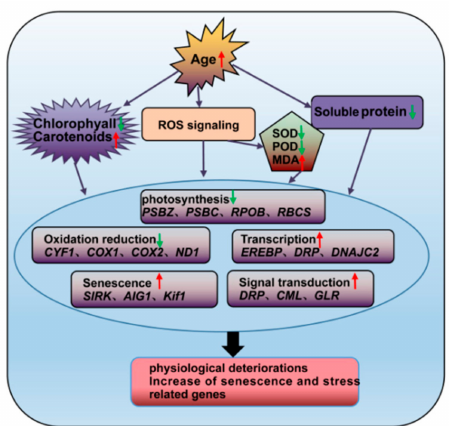
Figure 11. Schematic representation of the changes in the regulatory characteristics and gene expression levels of P. orientalis during aging. Red and green arrows represent ascend and descend, respectively.